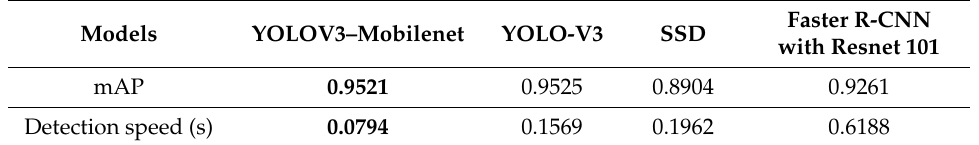
Table 6. mAP results and detection speed for several